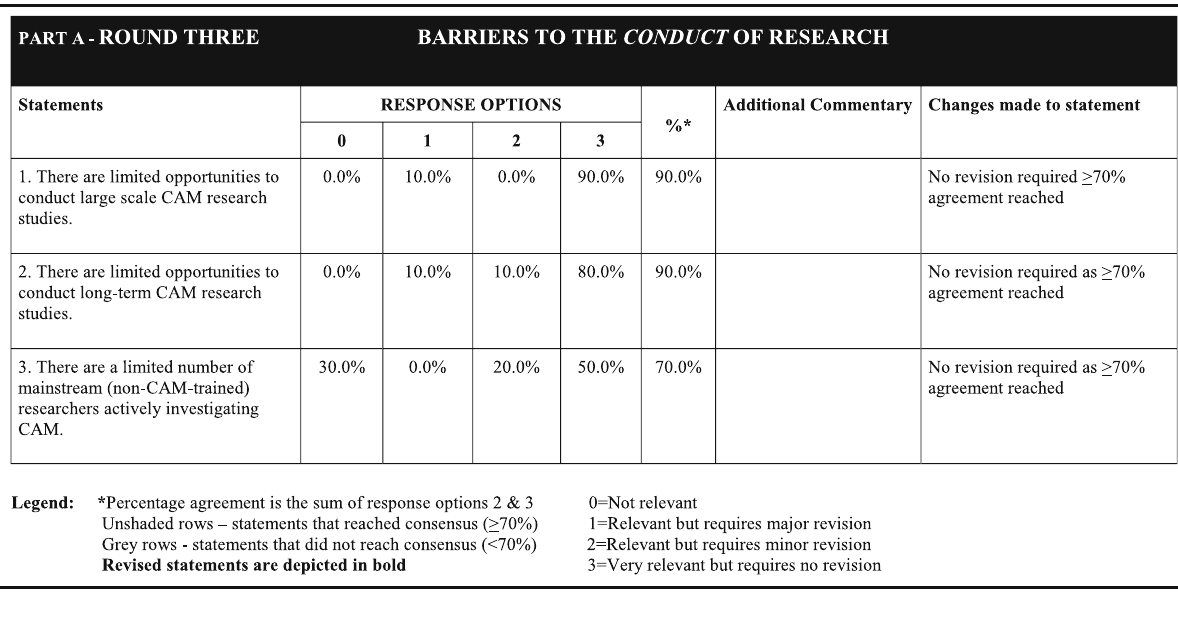
Table 5 Overview of participant responses to part A items from round